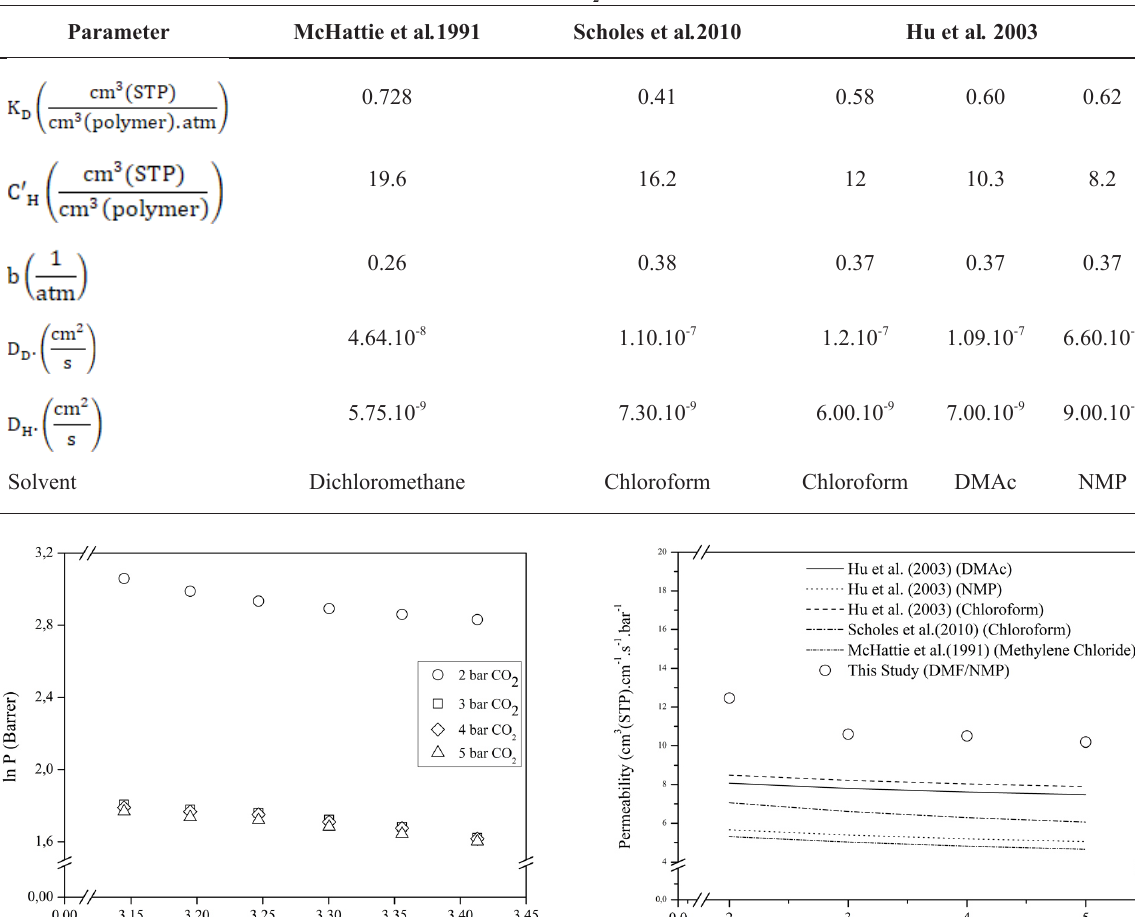
permeation in PSf membranes. 2